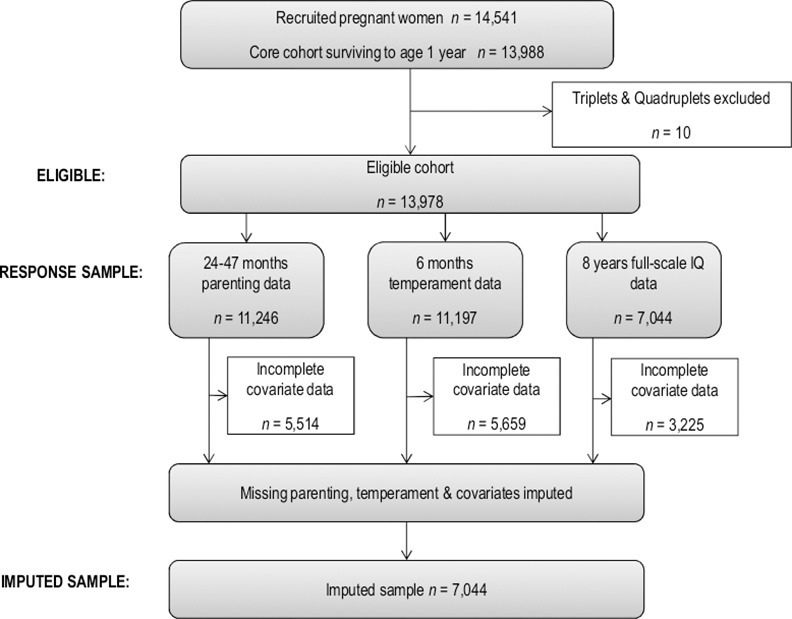
Eligible cohort and numbers included.